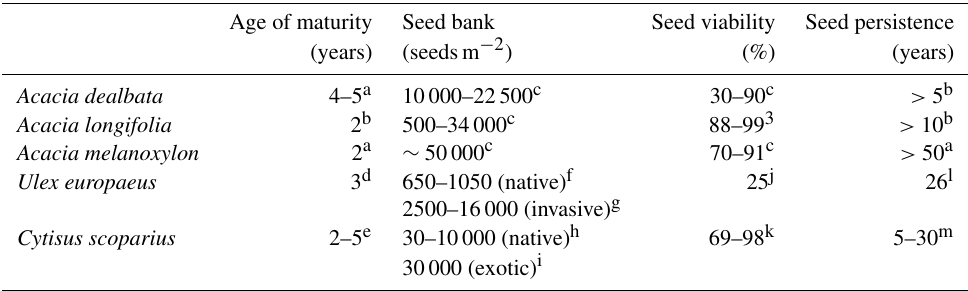
Table 5. Reproductive traits of the most widespread Acacia species in southern Europe and two abundant native legumes ( Ulex europaeus and Cytisus scoparius) in western